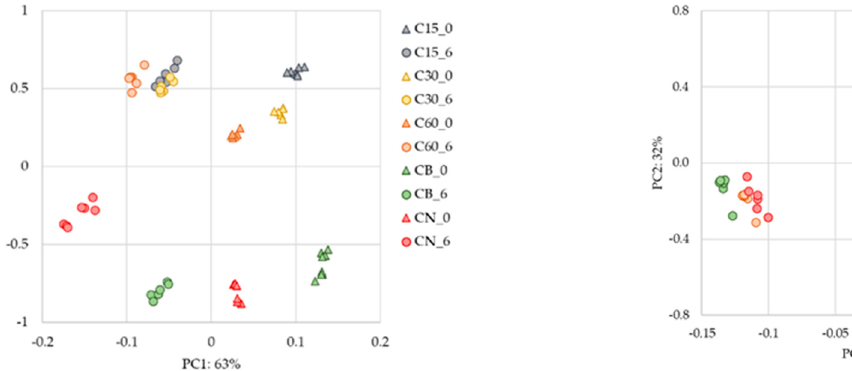
Figure 3. PCA was performed with spectral information of the AWS with chestnut (C) and with Limousin wood, acquired in NIR. Legend: C and L stand for the wood used in the ageing process, Chestnut and Limousin respectively; 15, 30 and 60 the different levels of micro-oxygenation used in the alternative system; N—no micro-oxygenation used in the alternative system; B—Barrel; 0—0 months in a bottle; 6—6 months in bottle.